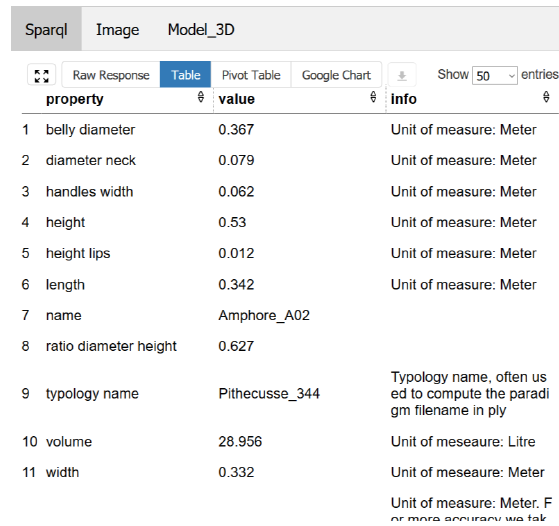
Figure 6: A Sparql query result tab view of the morphological attributes corresponding to Amphorae A02 as the selection in the Figure 4